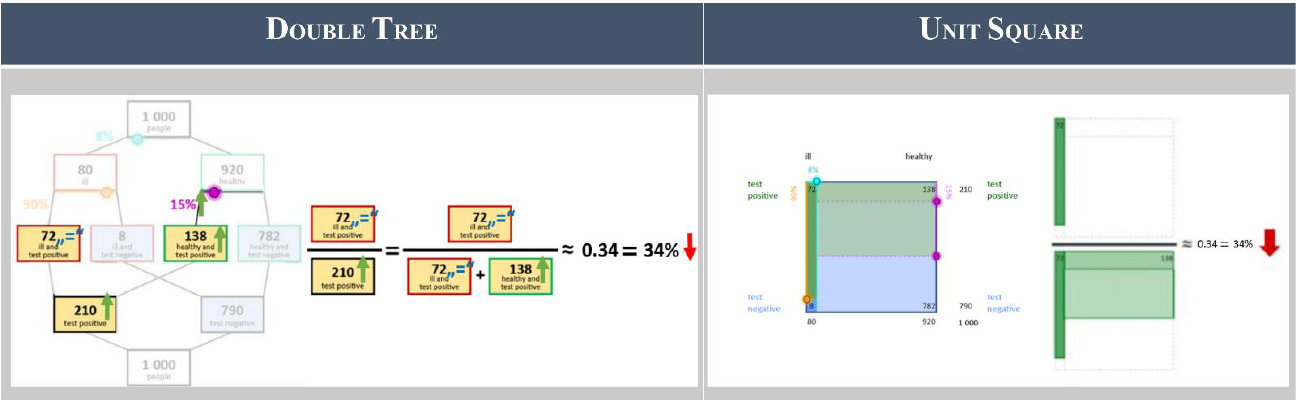
Figure 6. Mental models for the aspect of covariation.